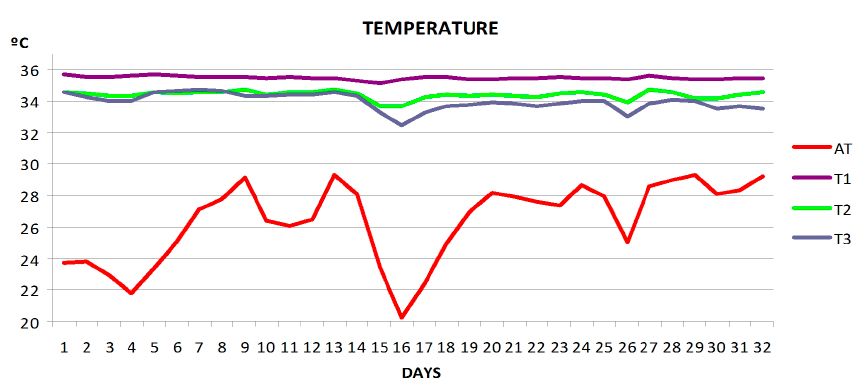
Figure 19. Average temperature per day of four hives over 32 days. Temperatures were registered at ambient (AT) and three areas inside the beehives: brood area (T1), area with honey/pollen reserves of in the periphery of the brood comb (T2), and in honeycombs